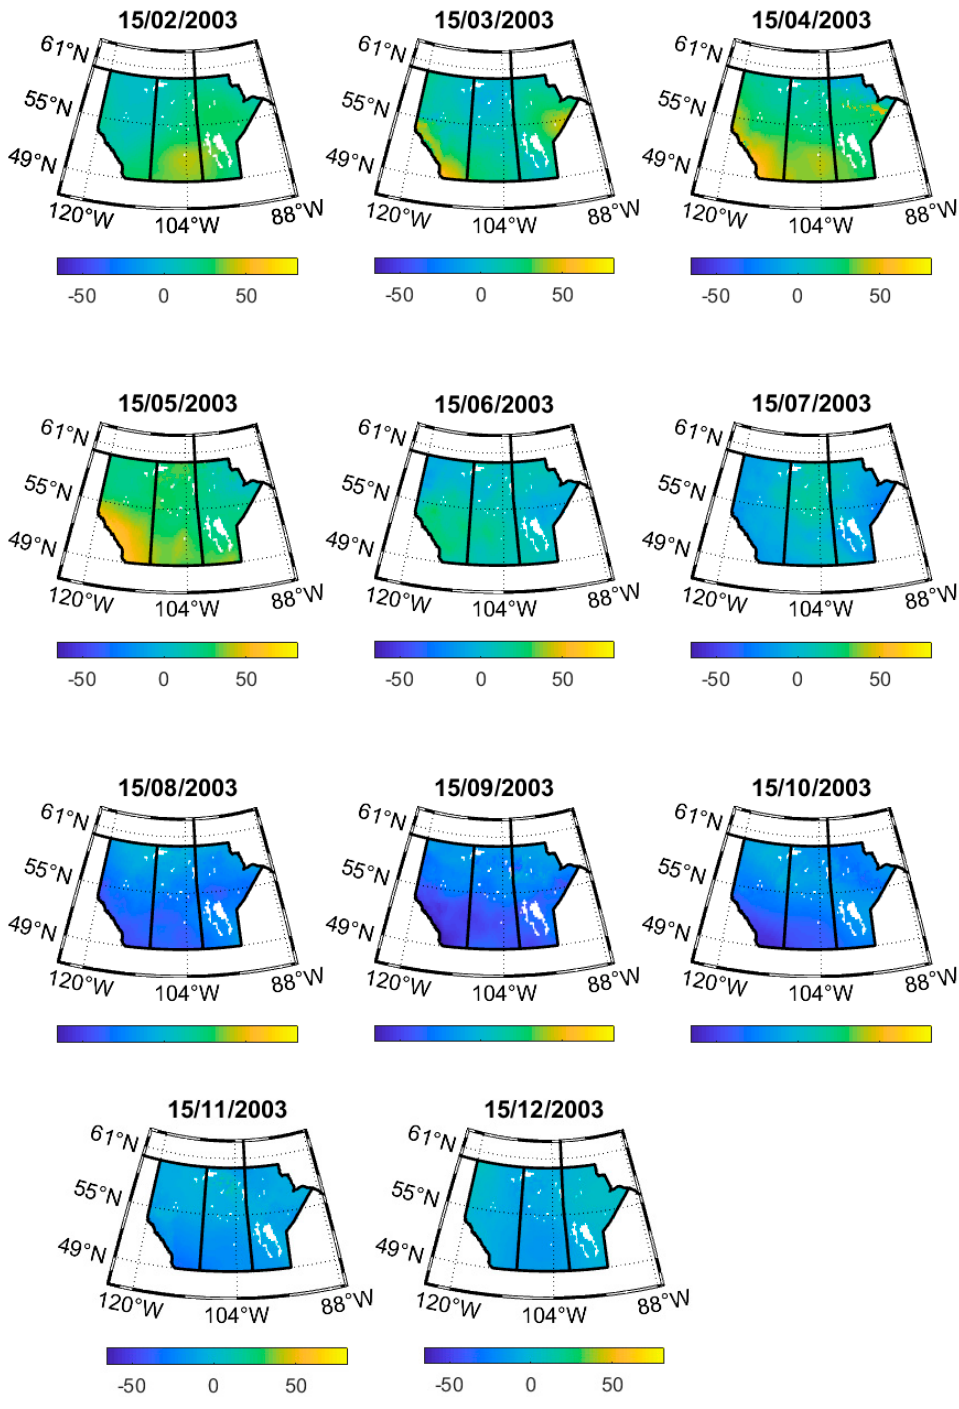
Figure 10. Downscaled GRACE groundwater storage anomalies (GWSA) over the study area on the 15th day of each month between February and December 2003 [mm].